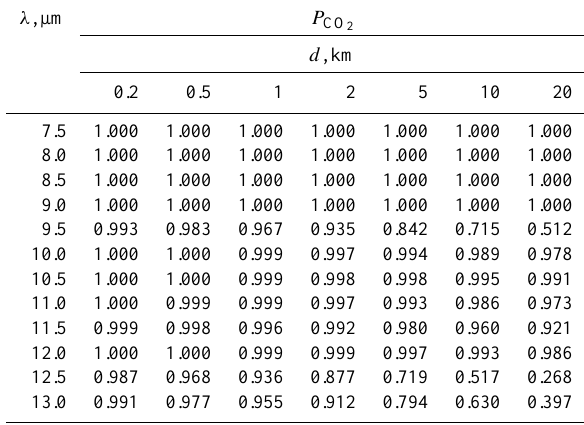
(Gaussorgues, 1994; Passman and Larmore, 2